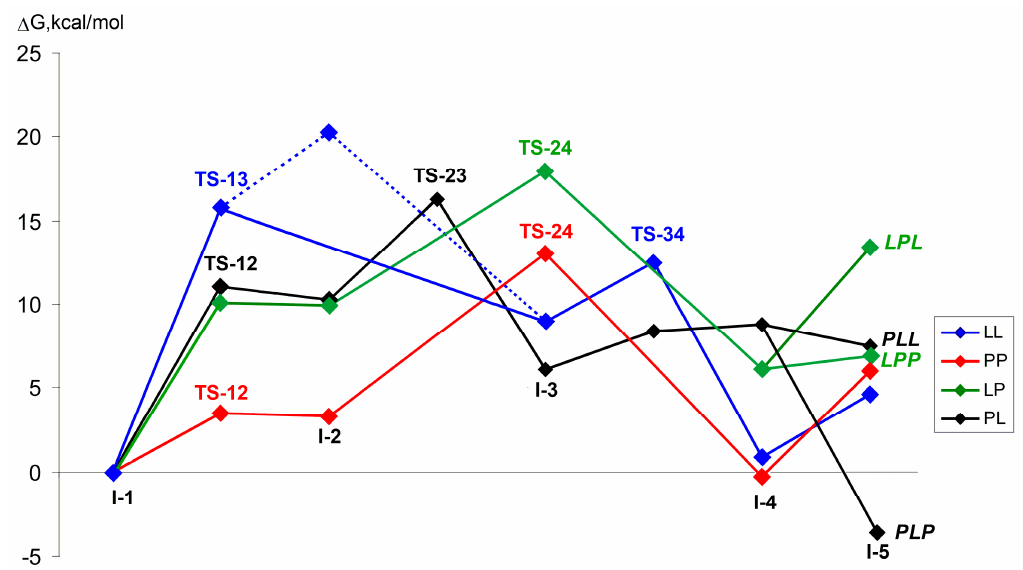
Figure 3. Calculated free energy profiles for all comonomer sequences of l -LA / MeOEP copolymerization based on data obtained earlier [51] and in this work.